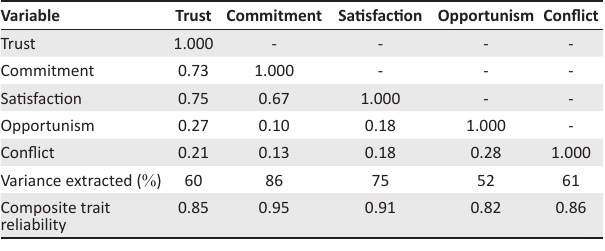
TABLE 3: Squared inter-construct correlations and summary statistics.